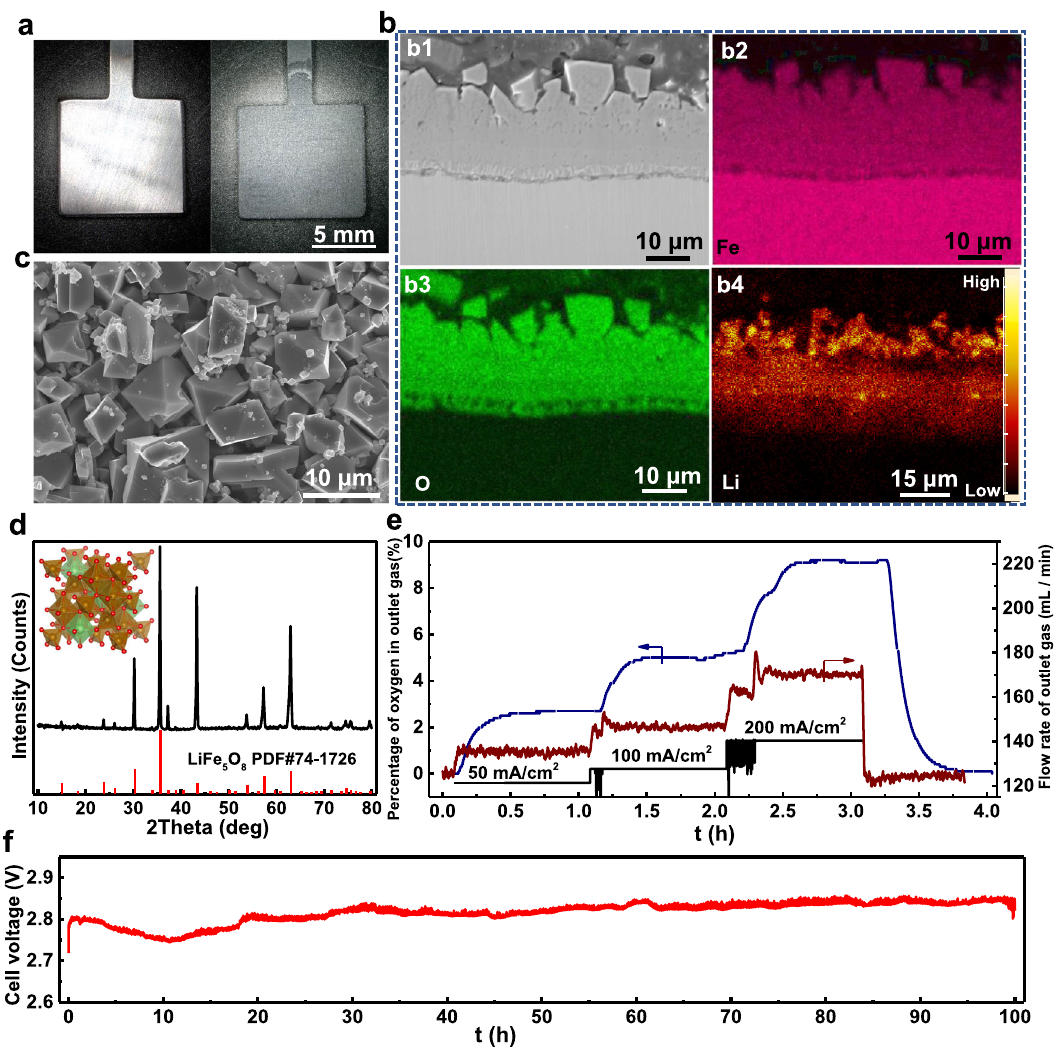
Fig. 2 | HT-OER performances of the Fe electrode in molten carbonates. a Optical graphs of the iron anode before and after pre-oxidation in molten car- bonates. b SEM image (b1), EDS mapping (Fe (b2), O (b3)), and SIMS mapping (Li (b4))ofthecross-sectionofoxidescale. c SEMimageoftheoxidescalethatdirectly